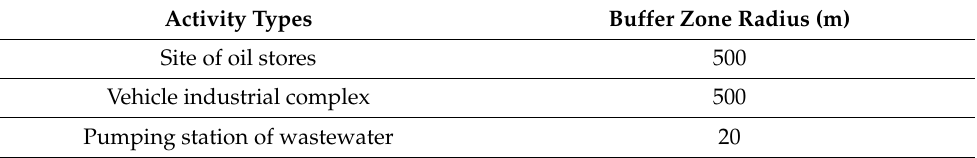
Table 3. Examples of low-polluting projects (Class C) according to Iraqi environment